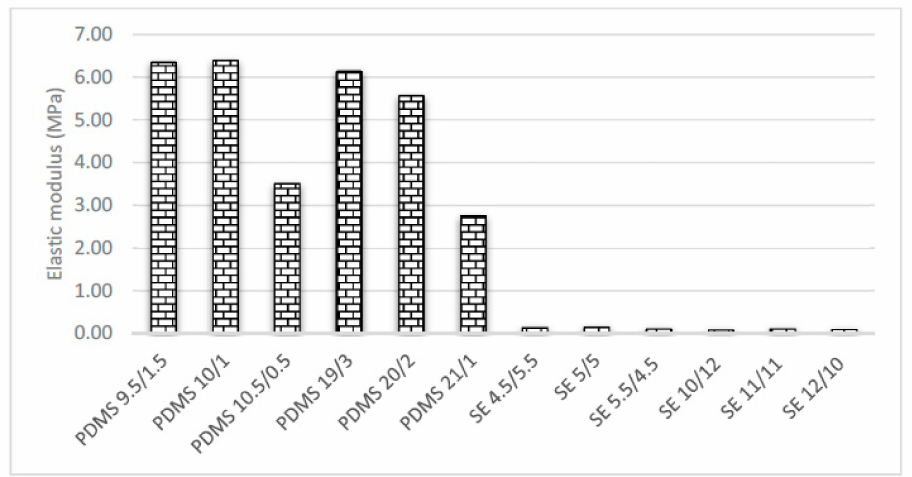
Figure 7. Elastic modulus for various mixtures and